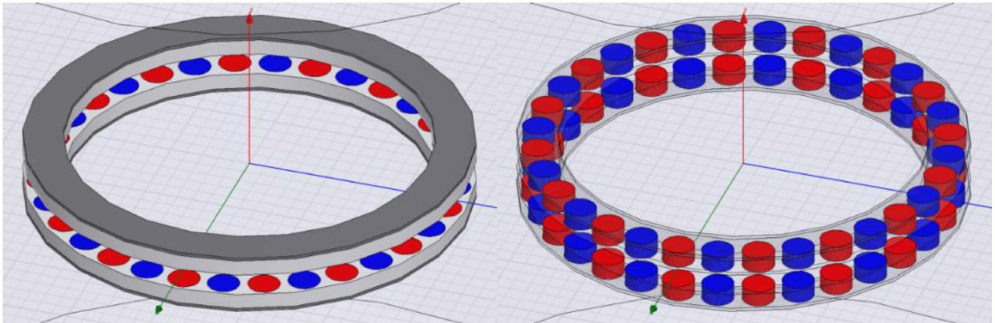
Figure 3. Magnet rings